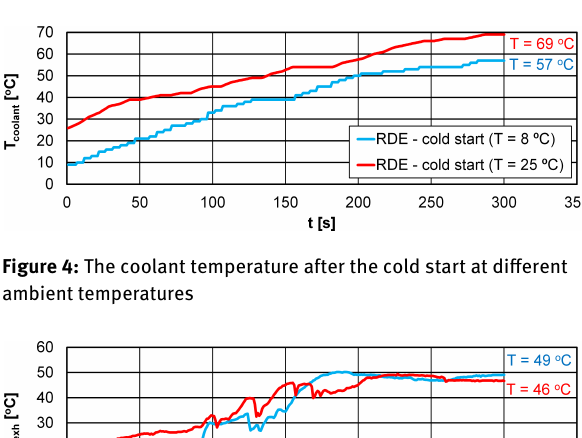
Figure 3: Vehicle velocity after the cold start at different ambient temperatures